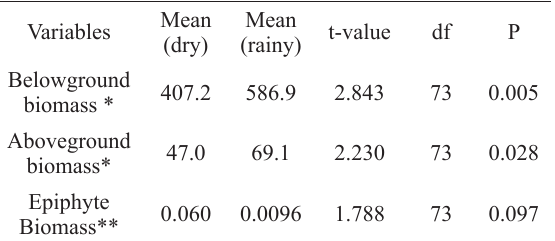
Variance analyses of the Halodule wrightii and Hypnea musciformis biomasses sampled in Goiabeiras Beach, Fortaleza-Ceará, Northeastern